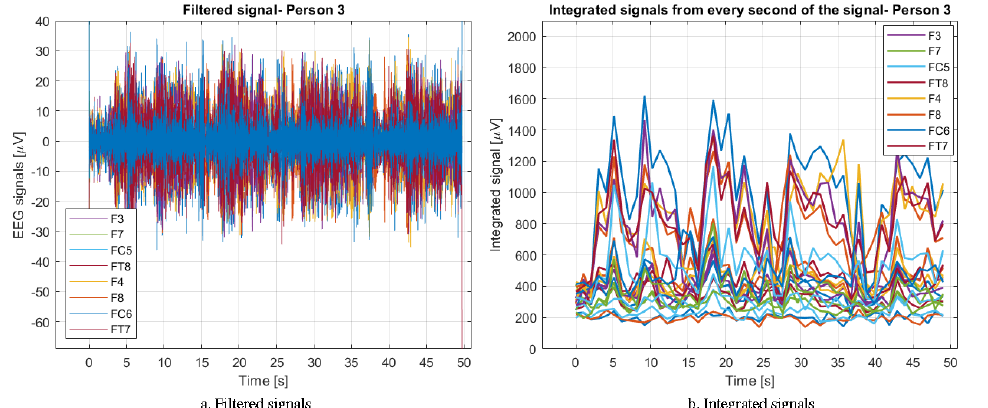
Figure 8. Comparison of filtered and integrated signals—Person